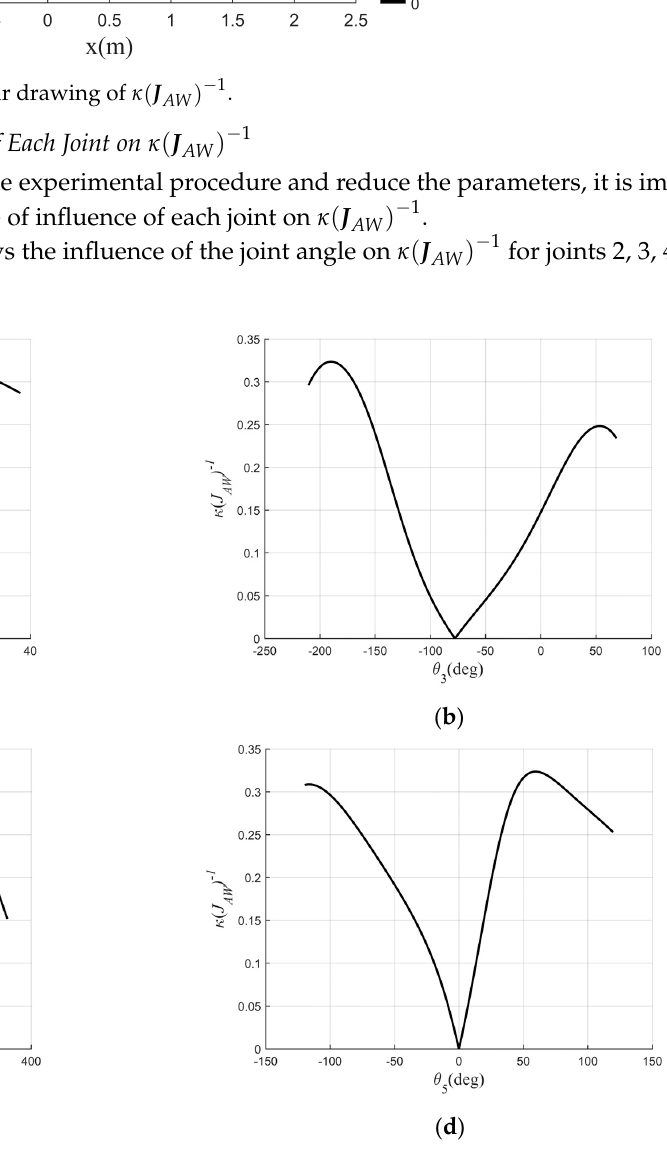
q is the angle of the i th joint of the robot; where i values of the corresponding joint angles; and values of the corresponding joint angles, respectively. Since the obtained optimal solutions for each group have similar in fl uences and trends on , a set of maximum poses with joint angles of [0° − 4.4822° − 99.912° 111.7901° 59.4099° 45°] were obtained to analyze the in fl uence of each joint on . ( − J . Figure 2. The contour drawing of